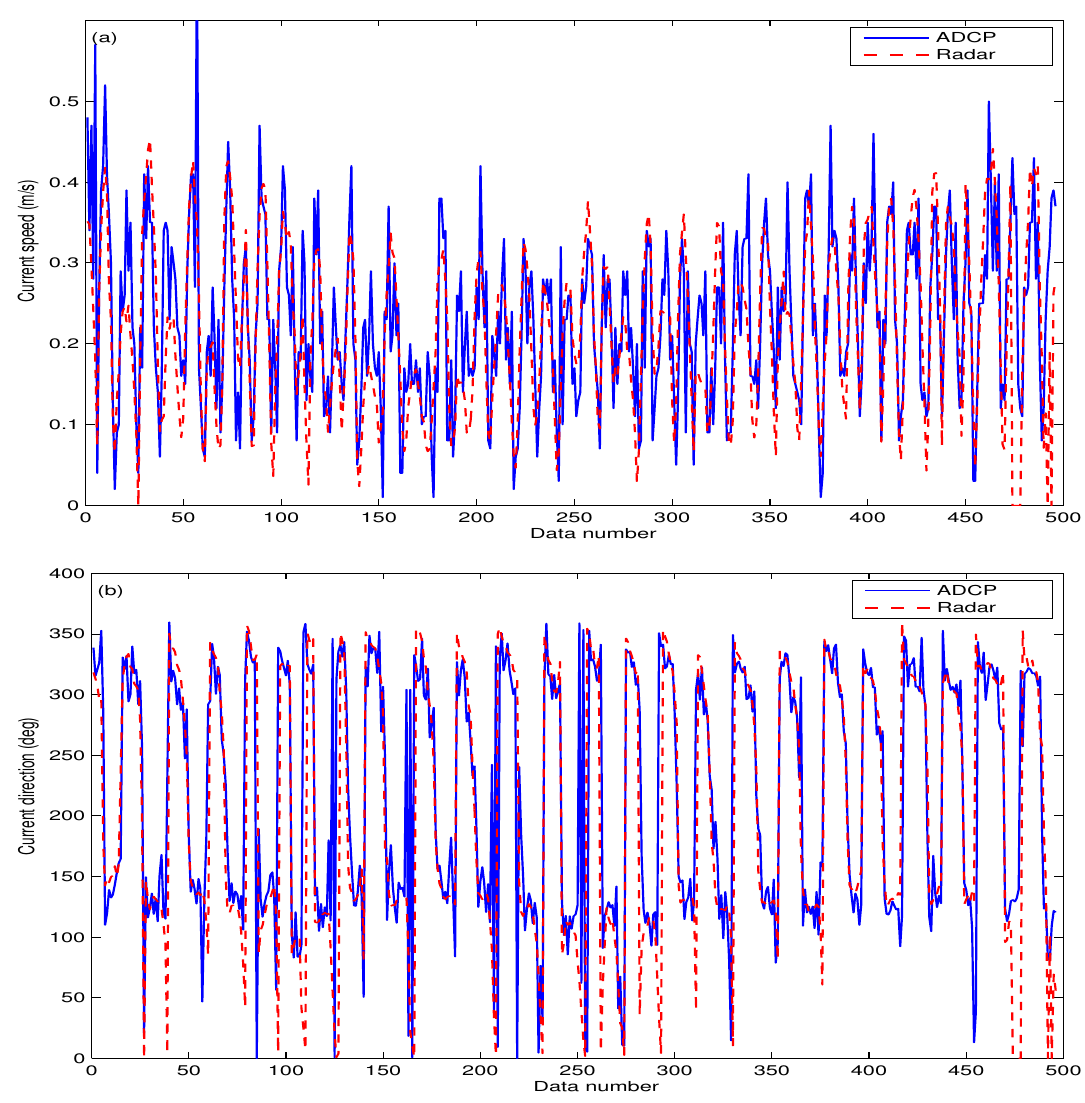
Figure 6. Comparison of acoustic Doppler current profiler (ADCP)-measured (at an 8-m depth) and radar-derived (polar current shell (PCS)) current: ( a ) speed; ( b )